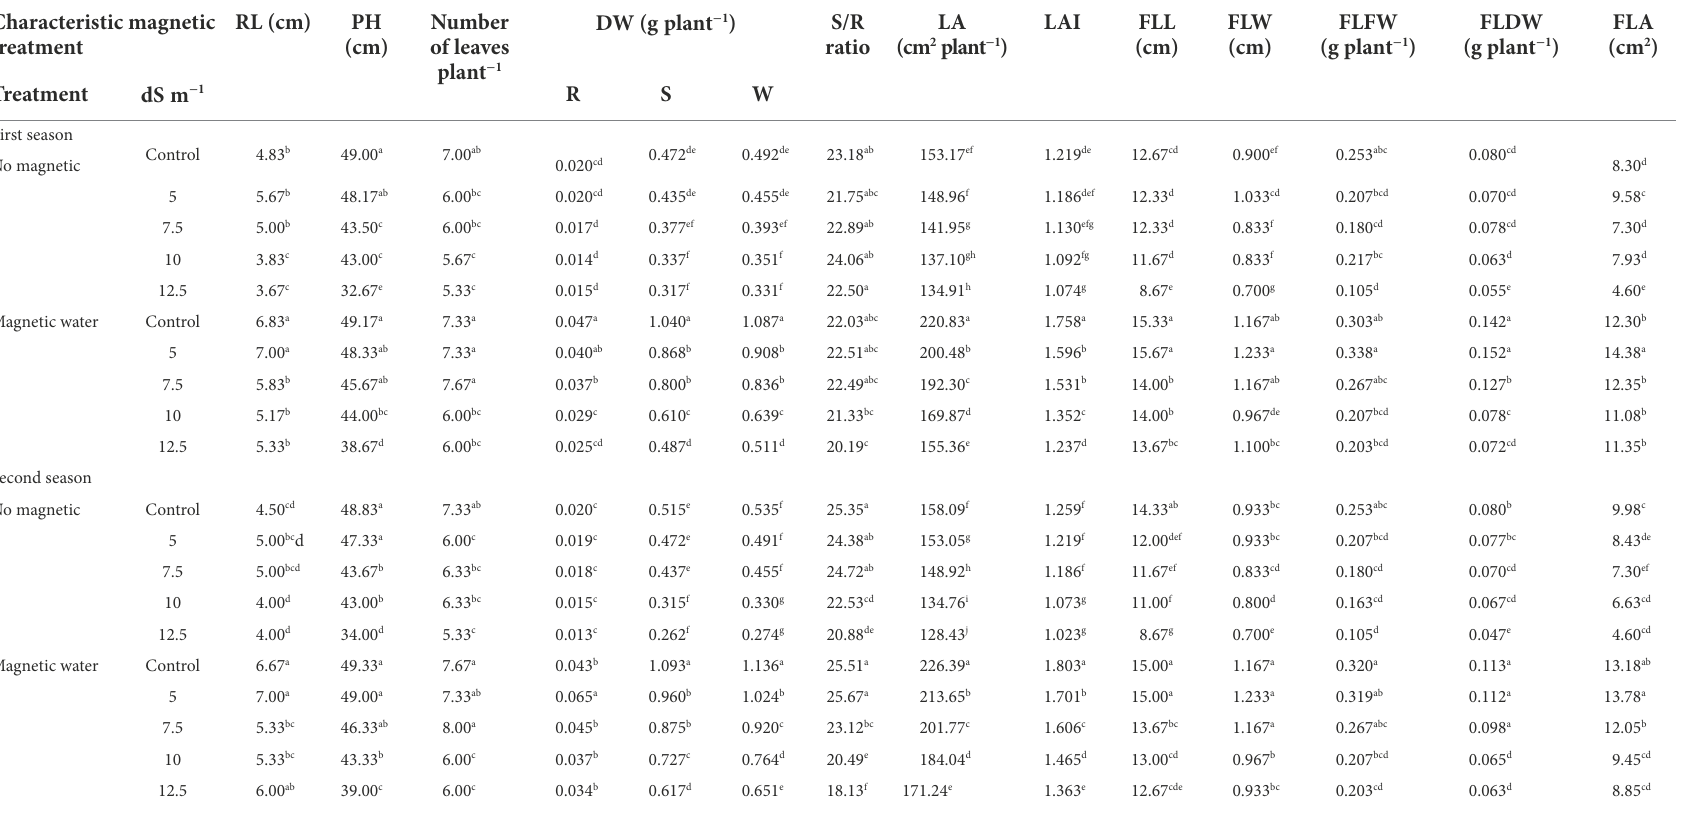
TABLE 2 Effect of seawater stress levels, magnetic treatment on some vegetative growth characters of wheat plants during the first and second growing seasons. Characteristic magnetic treatment